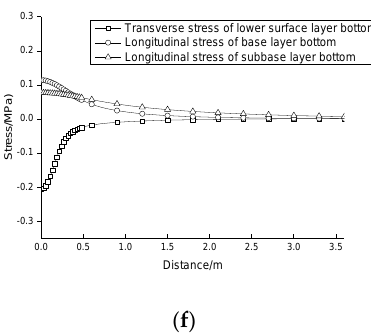
Figure 3. Stress variation diagram of key layers of three structures: ( a ) structure I under the double circle load; ( b ) structure I under the single circle load; ( c ) structure II under the double circle load; ( d ) structure II under the single circle load; ( e ) structure III under the double circle load; ( f ) structure III under the single circle load. Table 4. Maximum tensile stress of key layers under the uniform load of double circle (unit: MPa). Layer